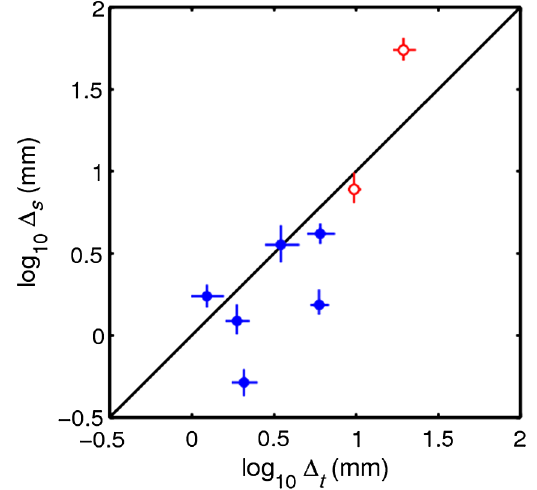
FIG. 6. Two estimates of the thicknesses of ancient stromatolite-forming microbial mats produce consistent values. (cid:1) is estimated from the relation between the curvature of a t lamina and the distance to the neighboring laminas. (cid:1) estimated from the shape of a single lamina. The black line shows equality. The measured slope is m ¼ 2 : 3 (cid:8) 1 : 6 , consistent with the predicted value m ¼ 1 . The intercept b < 0 reflects that (cid:1) is systematically larger than the estimate of (cid:1) t points represent stromatolites from the 2 : 9 (cid:1) 10 9 -yr-old Pongola Formation [38]. Open red points are from Proterozoic